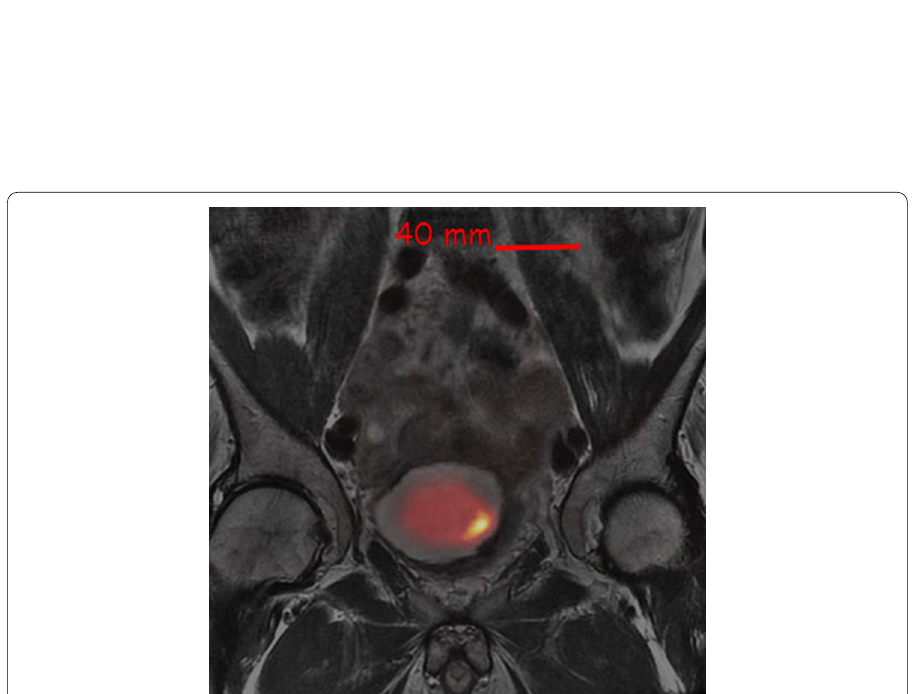
Fig. 3 Fused PET and MRI, using bone as the landmark